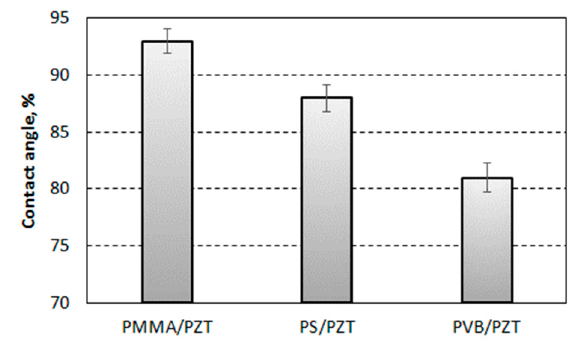
Figure 12. Mean contact angle of a water droplet on PZT composite surface.